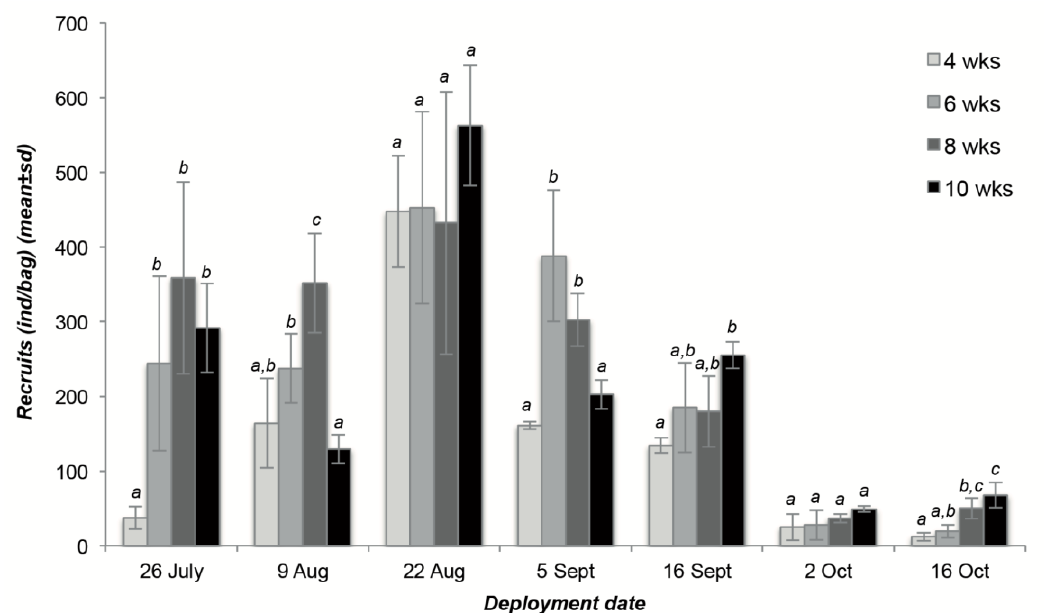
Figure 2. Immersion time. Spat abundances of the three scallop species found on collectors retrieved after 4, 6, 8, and 10 weeks. At each deployment time different letters indicate significant differences (Post-hoc analysis, SNK; p < 0.05). Table 1. Two-way ANOVA to test the effect of immersion time and deployment time on spat abundances.